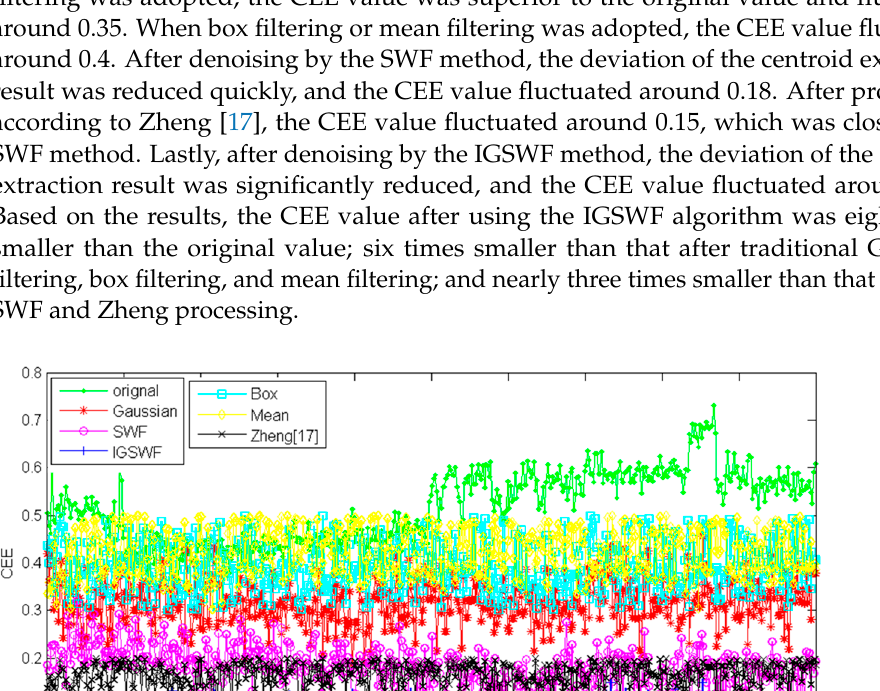
Table 2. The identification rate.